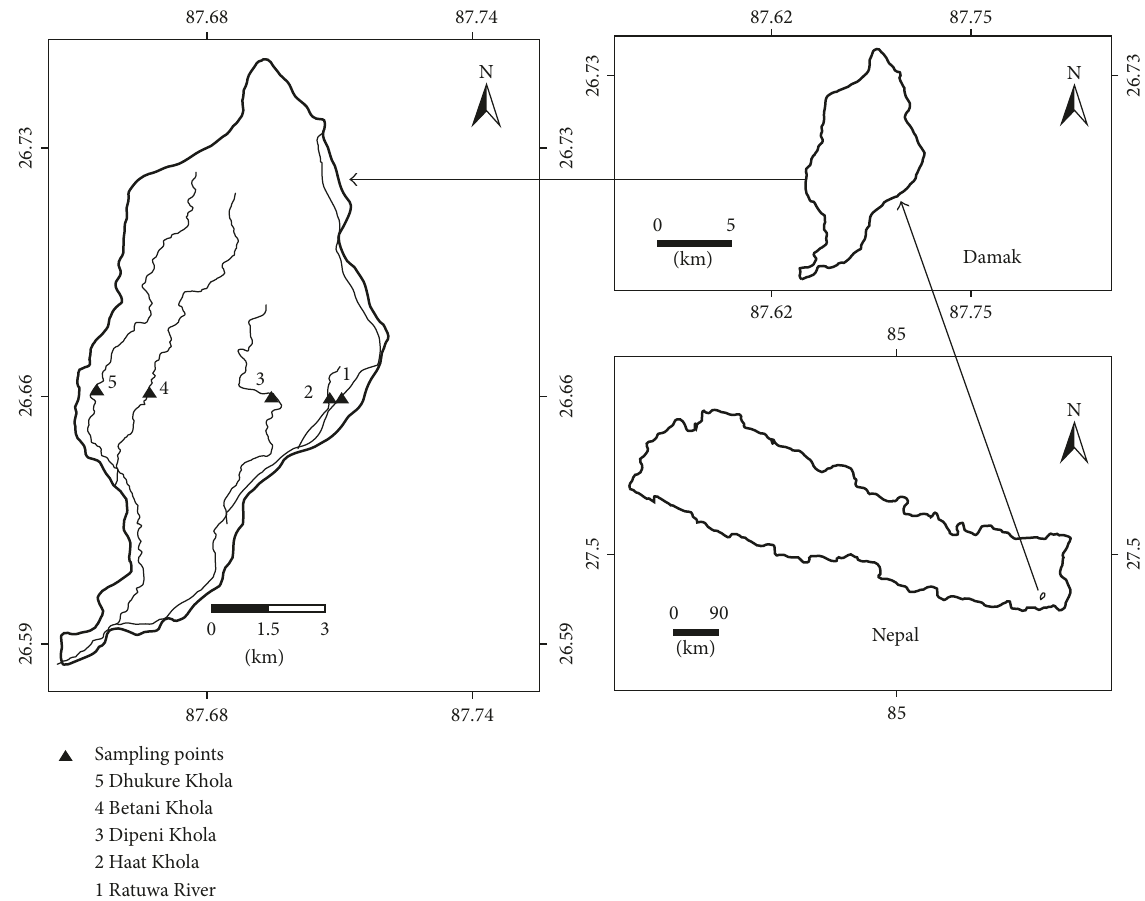
Figure 1: Location of the study site showing the sampling points inserted in the map of